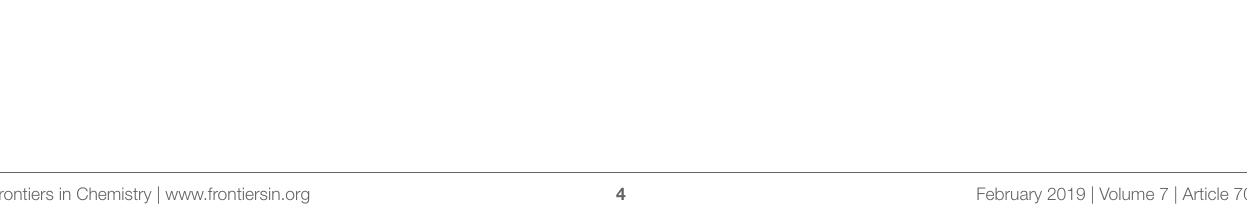
Frontiers in Chemistry | www.frontiersin.org